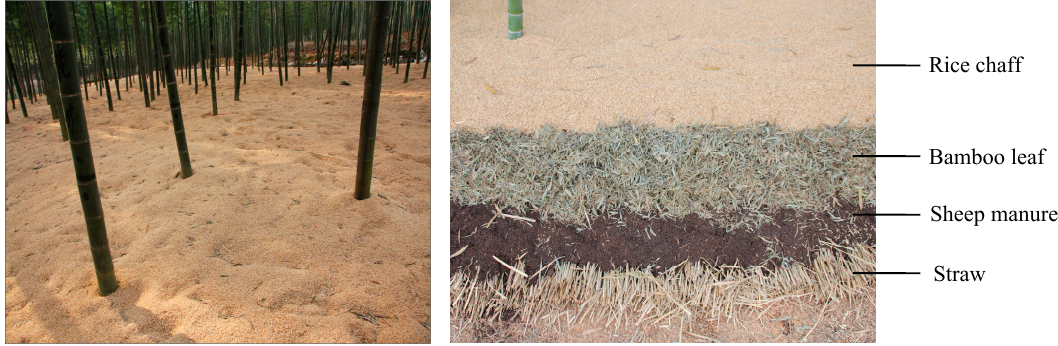
Figure 1. Photos of the experimental fields and the descriptions of mulching management.